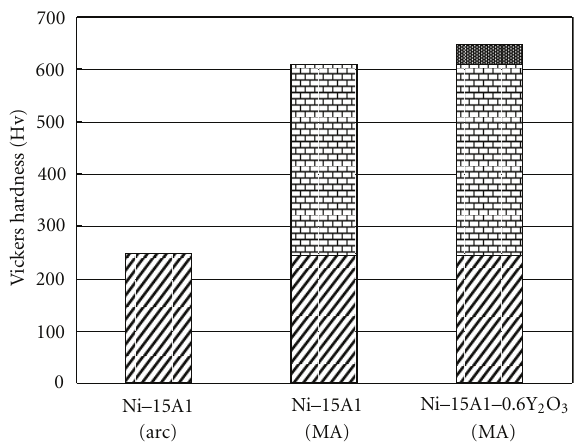
Figure 1: Vickers hardness at as-fabricated condition.